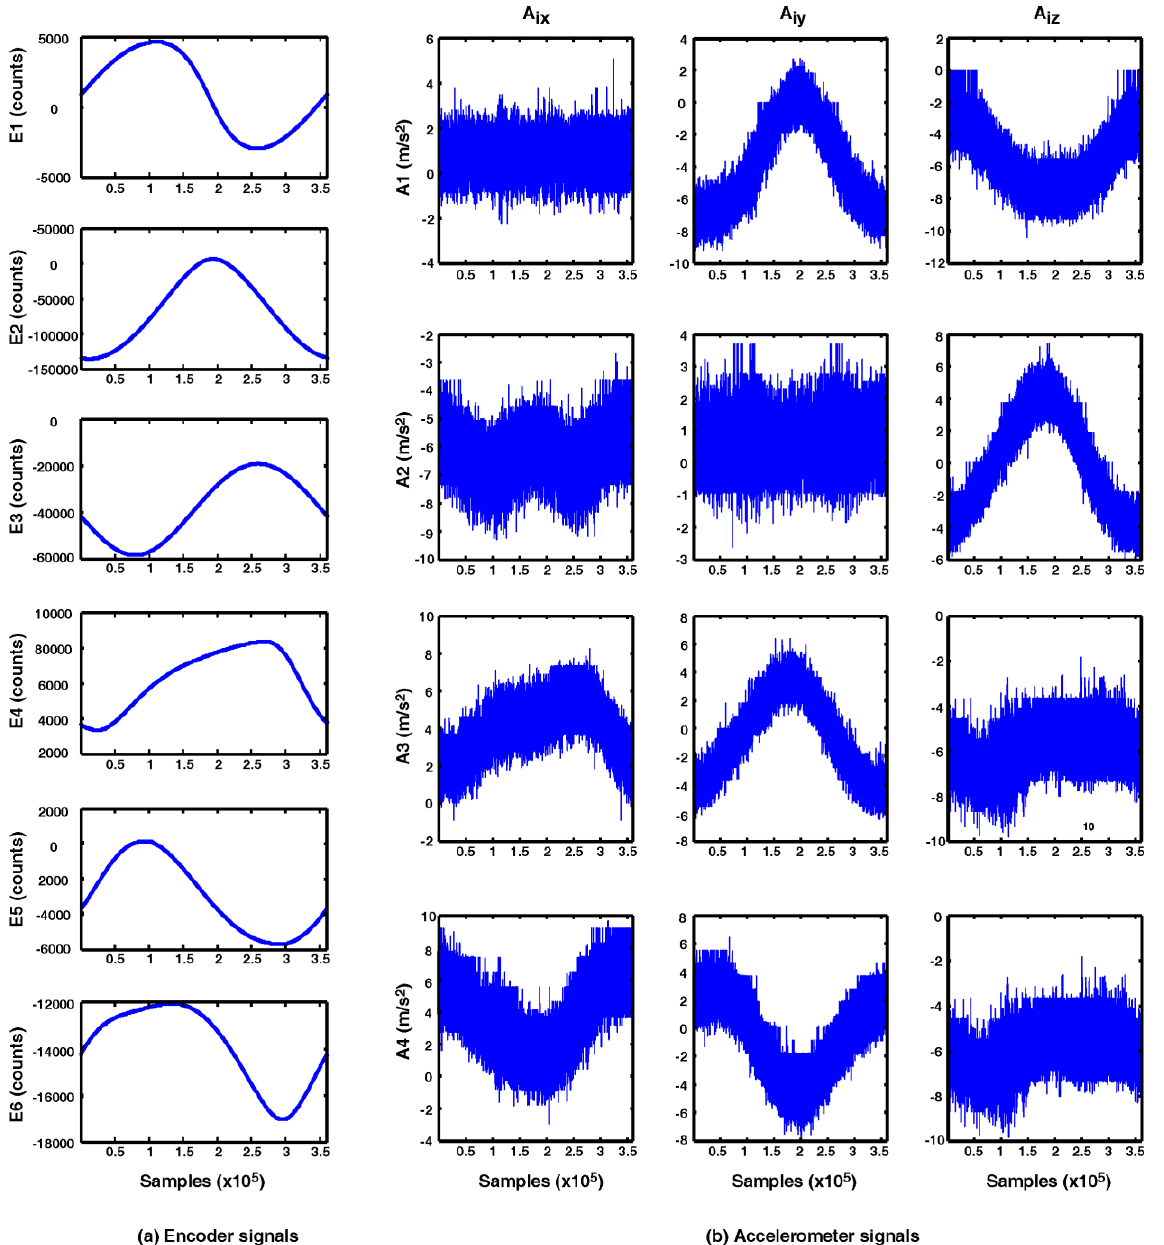
Figure 8. Monitored sensor network signals for the case of a circle path. (a) Encoder signals. (b) Accelerometer